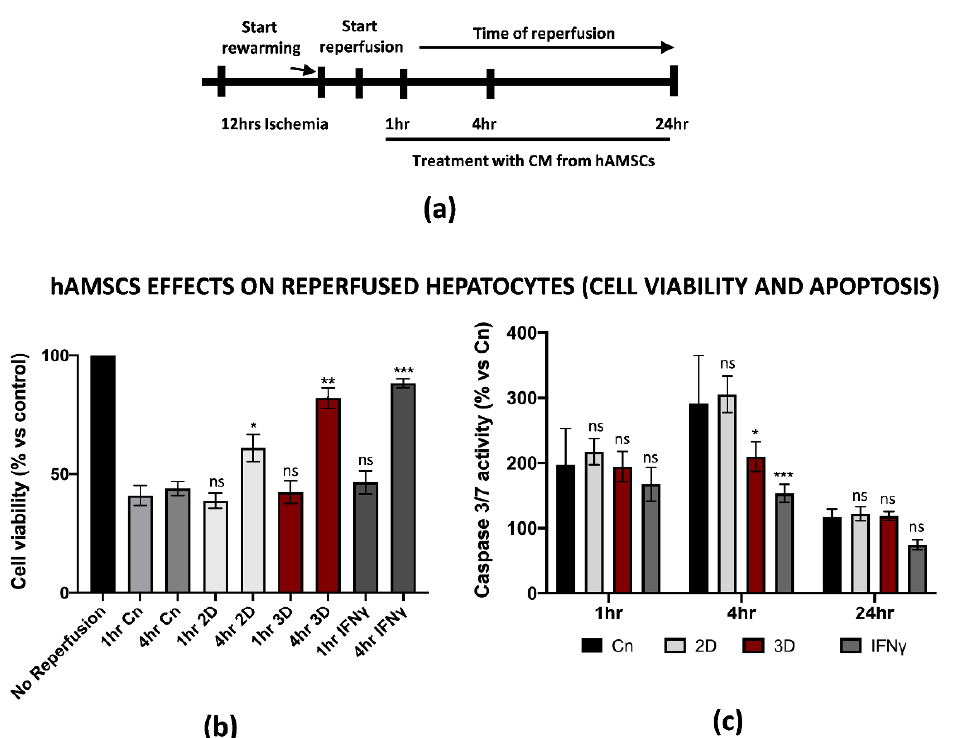
Figure 5. Conditioned medium from primed hAMSCs improved hepatic cell viability and reduced apoptosis after in vitro IRI. ( a ) Schematic representation of the modified IRI protocol applied to THLE-2 macrophages. ( b ) Cell viability analysis of THLE-2 reperfused at different timepoints with pre-conditioned CM from hAMSCs. Data are represented as % vs. control (mean ± std). Statistical significance has been calculated via ordinary one-way ANOVA (Dunnet’s multiple comparisons test, n = 3, * = p < 0.05; ** = p < 0.005; *** = p < 0.0005; ns = not significant). ( c ) Caspase 3/7 analysis in THLE-2 hepatocytes after reperfusion at the timepoints in presence of pre-conditioned CM from hAMSCs. Data are represented % vs. control (mean ± std). Statistical significance has been calculated via ordinary one-way ANOVA (Dunnet’s multiple comparisons test, n = 3, * = p < 0.05; *** = p < 0.0005; ns = not significant).